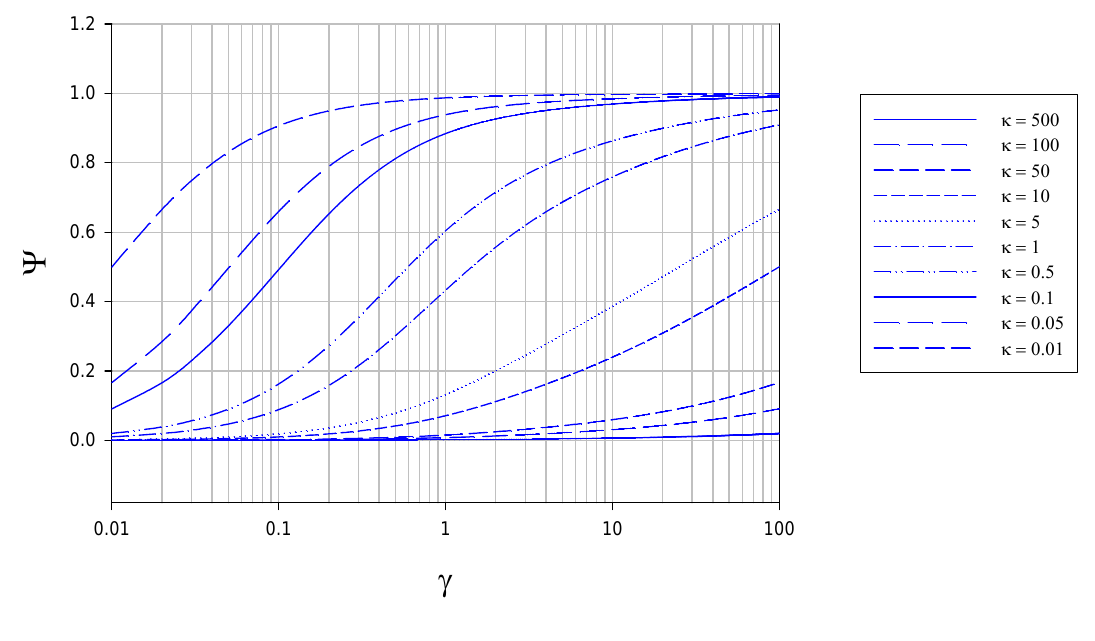
Figure 6. Variation of normalized flux Ψ with reaction/diffusion parameter γ for various fixed values of the parameter κ . The curves were calculated using eqn.26 in the